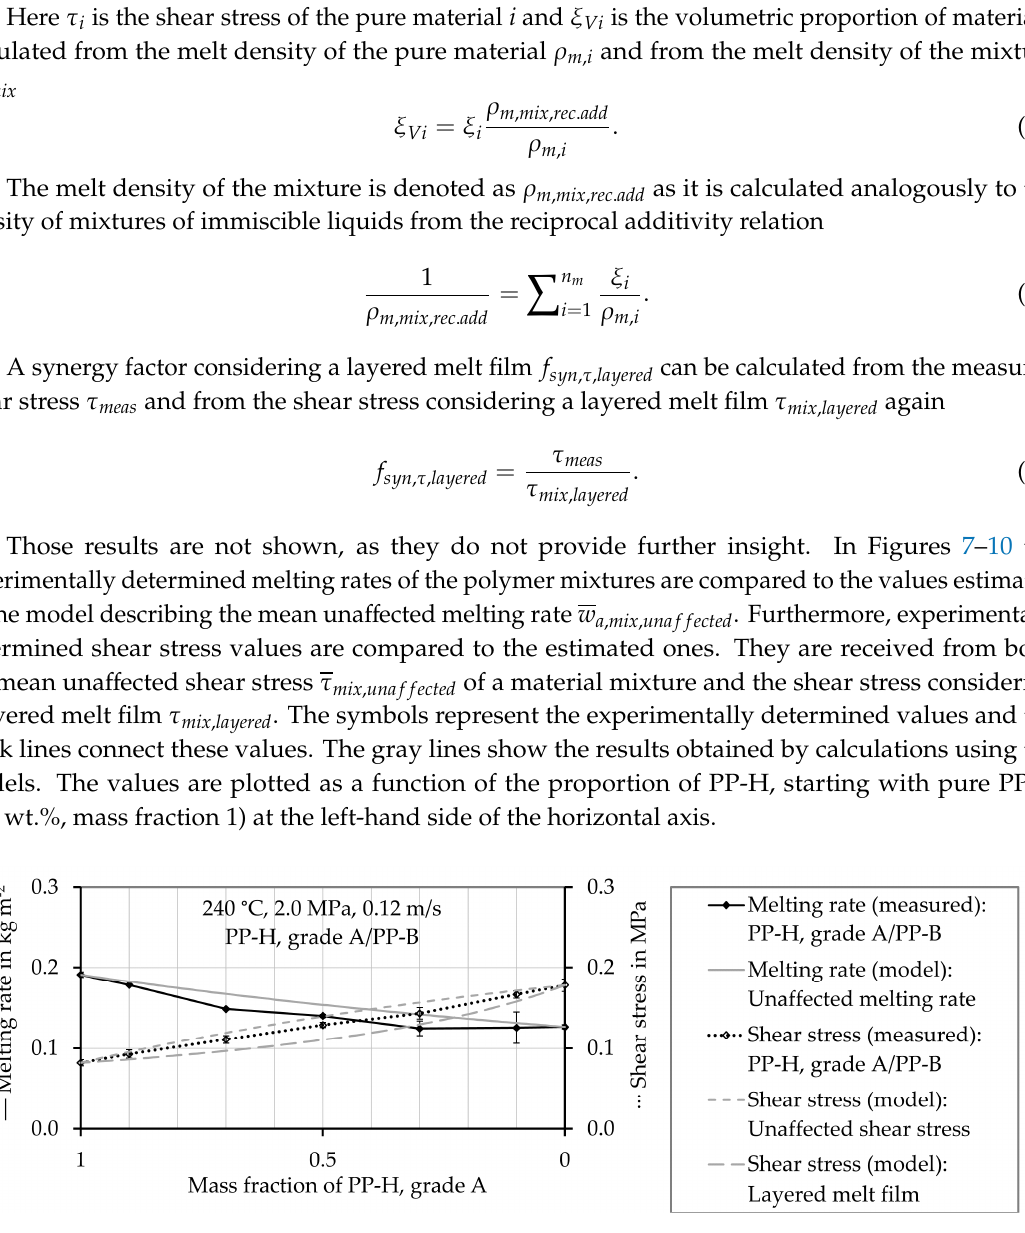
Figure 7. Measured and estimated values of the melting rate and shear stress of the mixture of PP-H, grade A and PP-B at a temperature of 240 °C.